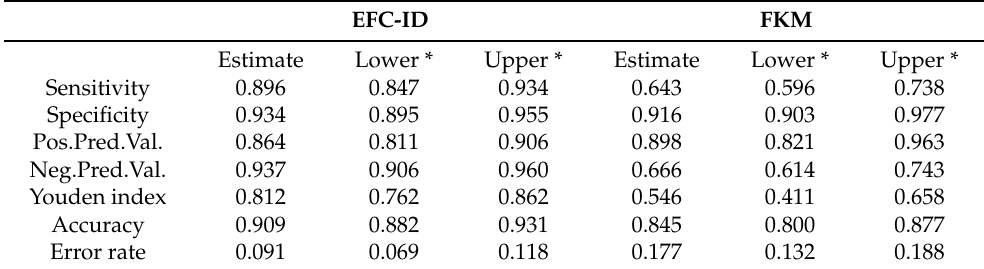
Table 6. Performance indexes obtained by EFC-ID and FKM for malignant breast cancer diagnosis. EFC-ID FKM Estimate Lower * Upper * Estimate Lower * Upper